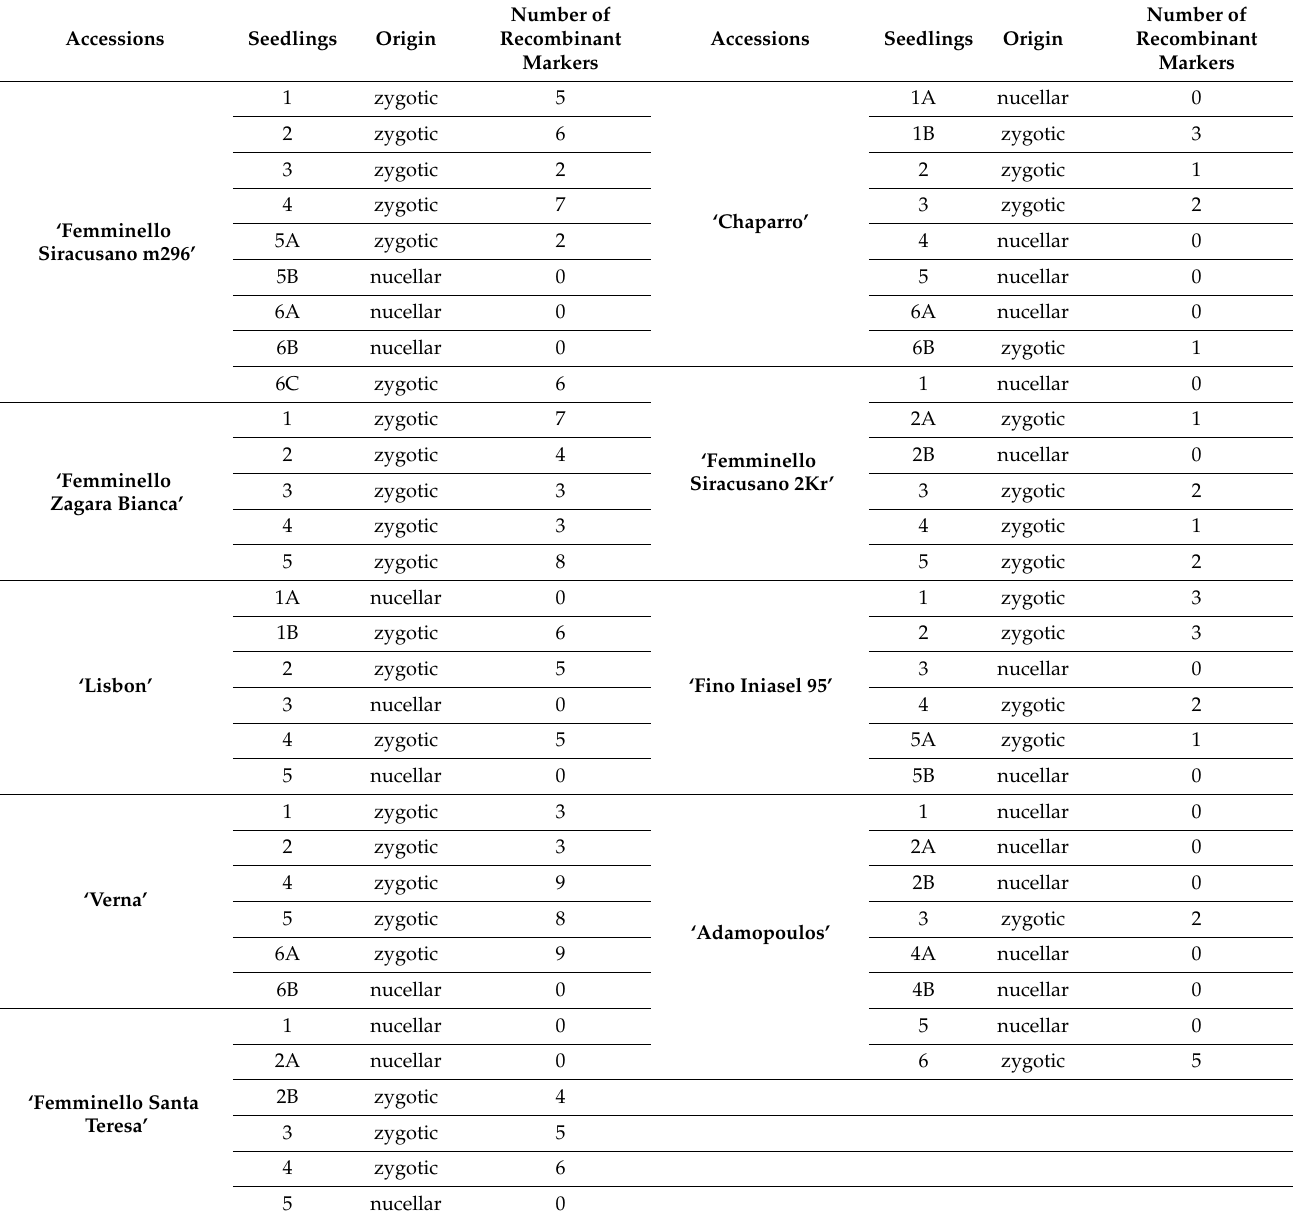
Table 4. Results of the considered 11 molecular markers analyzed on 69 seedlings from 9 genotypes in order to identify zygotic and nucellar